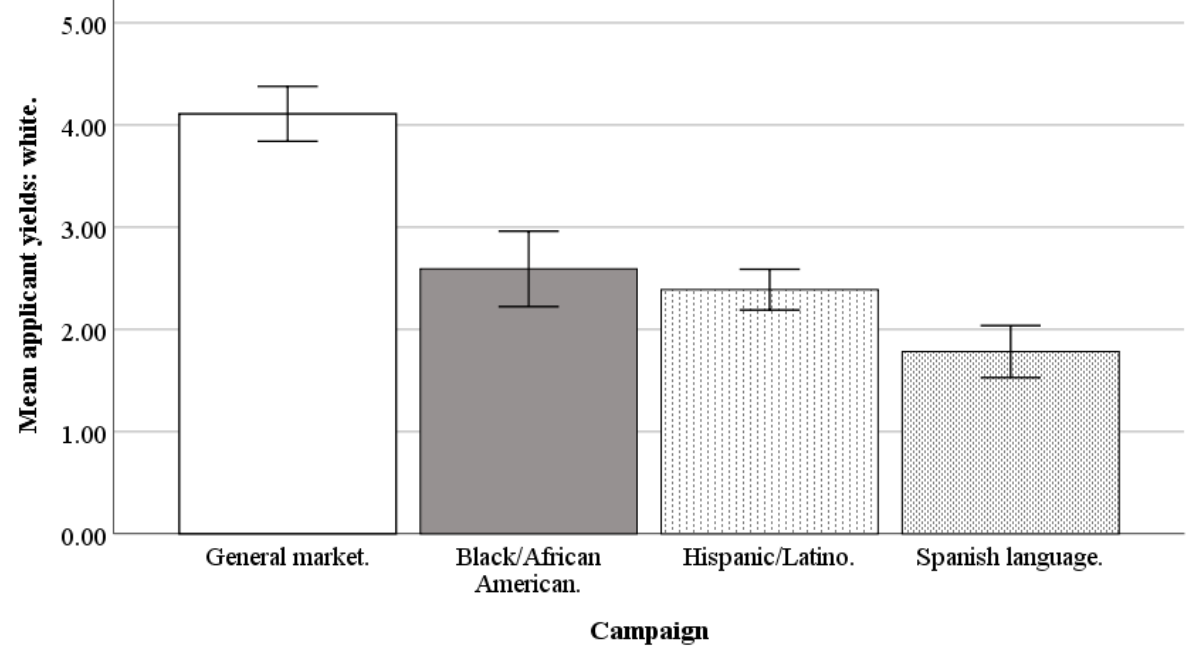
Figure 4. Mean applicant yields of whites for Facebook advertising